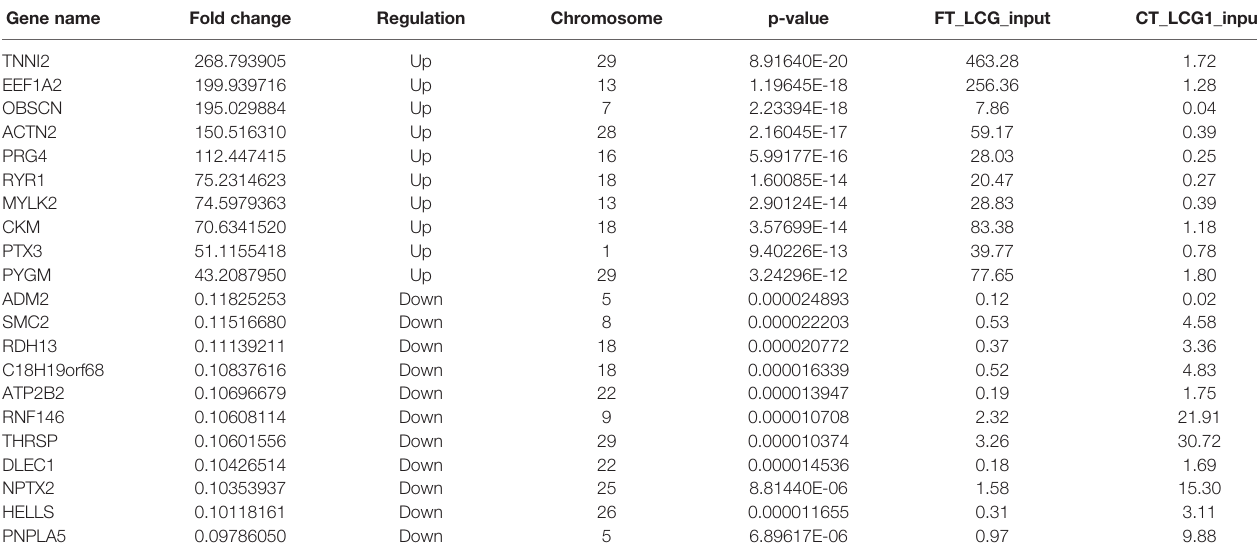
TABLE 4 | The top 20 differentially expressed